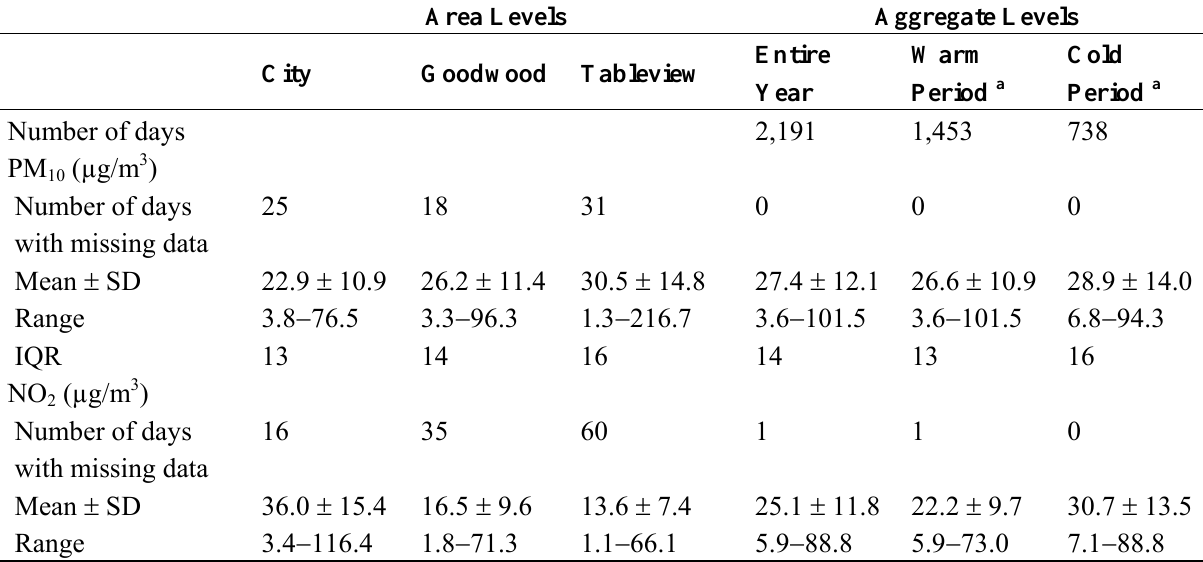
Table A1. Air pollutant levels and meteorological conditions measured at three sites in Cape Town, South Africa,